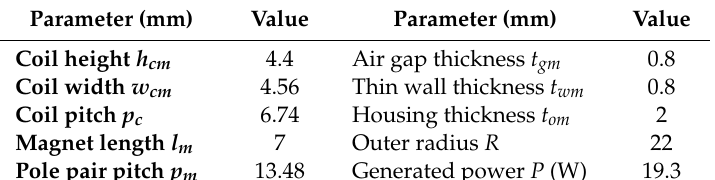
Table 1. Optimal parameters of the energy-harvesting part.